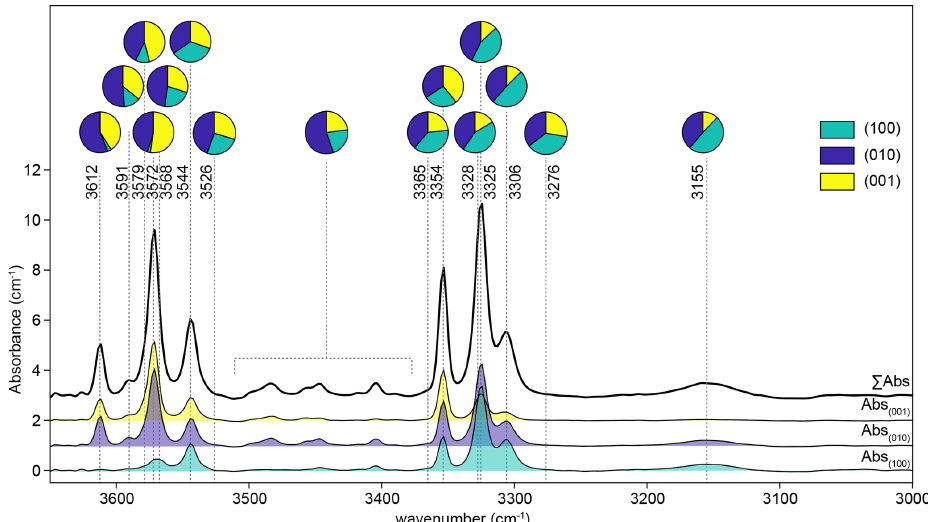
Figure 1. Unpolarised spectra recorded for three perpendicular planes from the sample from experiment HYCRa6. The top spectrum is the total absorbance, calculated as the sum of the other three. The three recorded spectra were then resolved into Gaussian peaks by peak fitting, and the relative peak heights in each orientation are shown as pie charts. The 3380–3510cm − 1 region was numerically